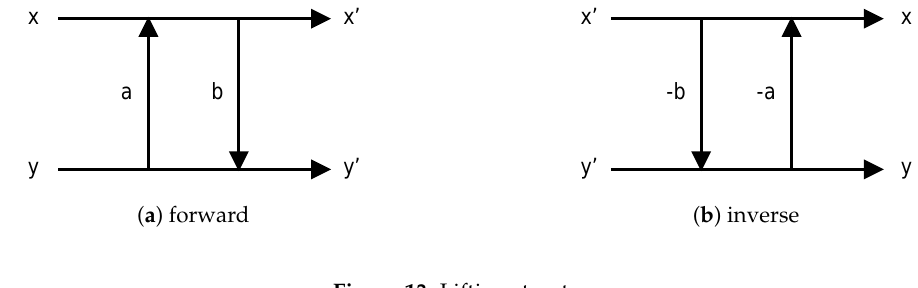
Figure 13. Lifting